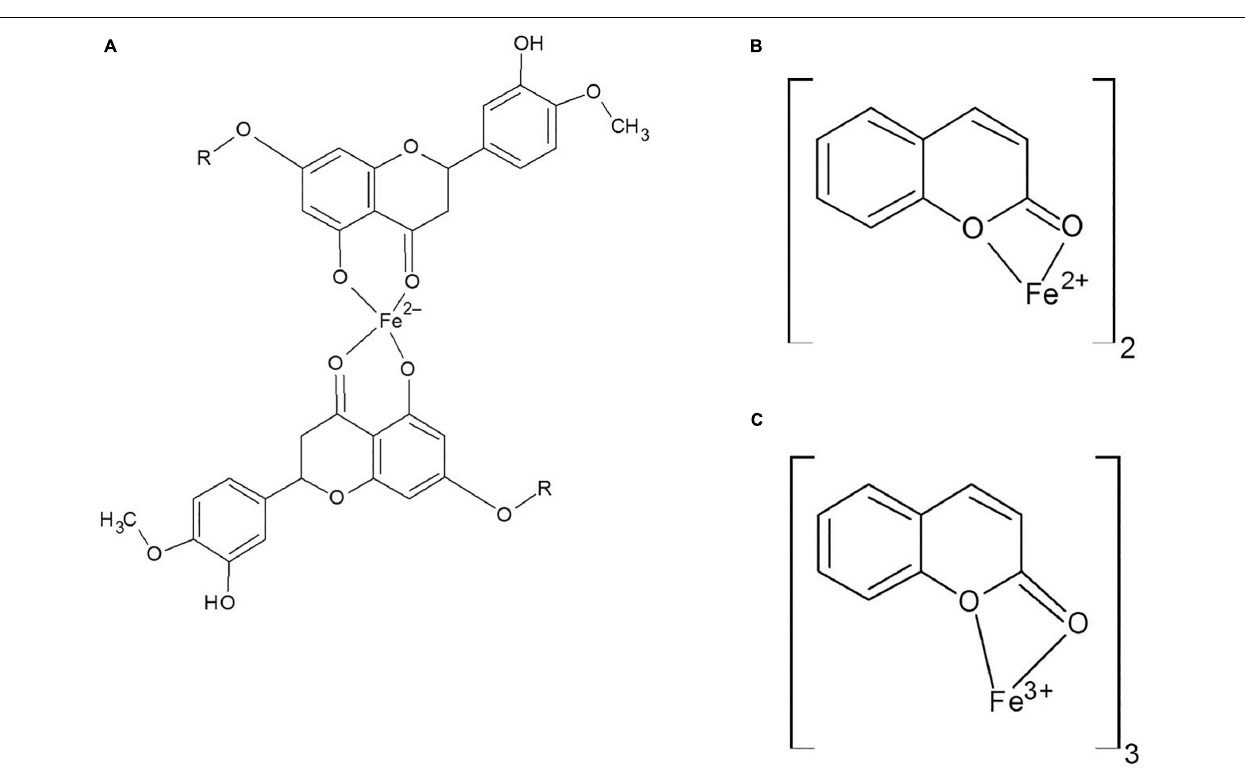
FIGURE 8 | (A) Hesperidin and Fe binding site, (B,C) Coumarin and Fe 2 + and Fe 3 +